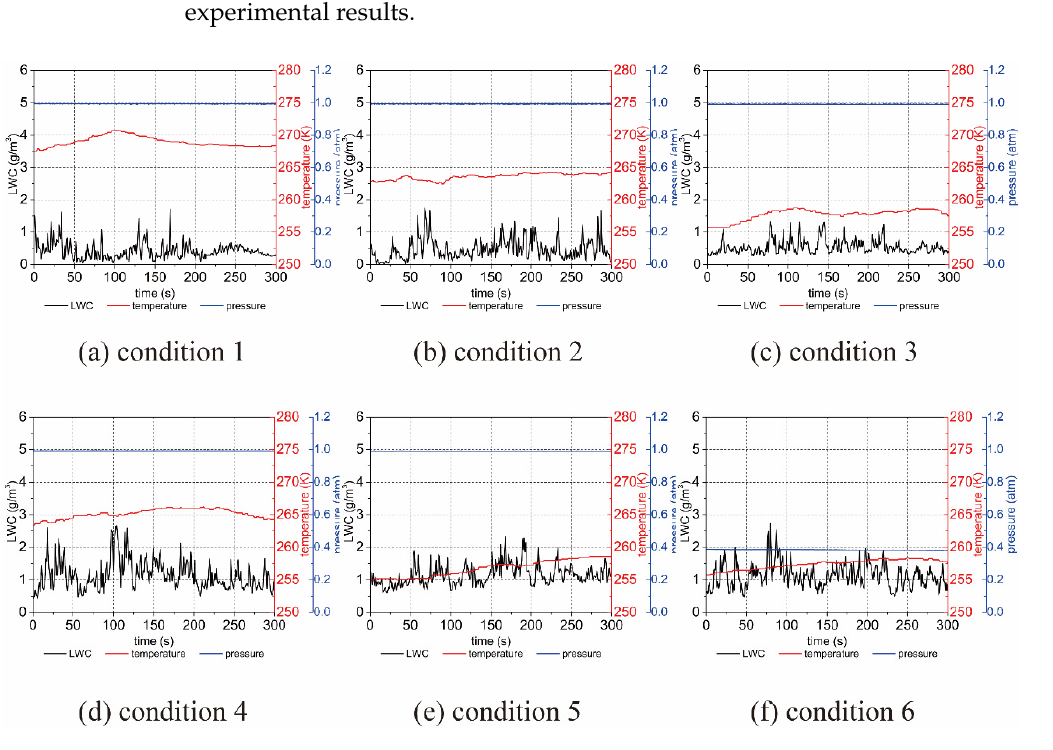
Figure 3. The typical parameters of cloud chamber in ( a ) condition 1, ( b ) condition 2, ( c ) condition 3, ( d ) condition 4, ( e ) condition 5, and ( f ) condition